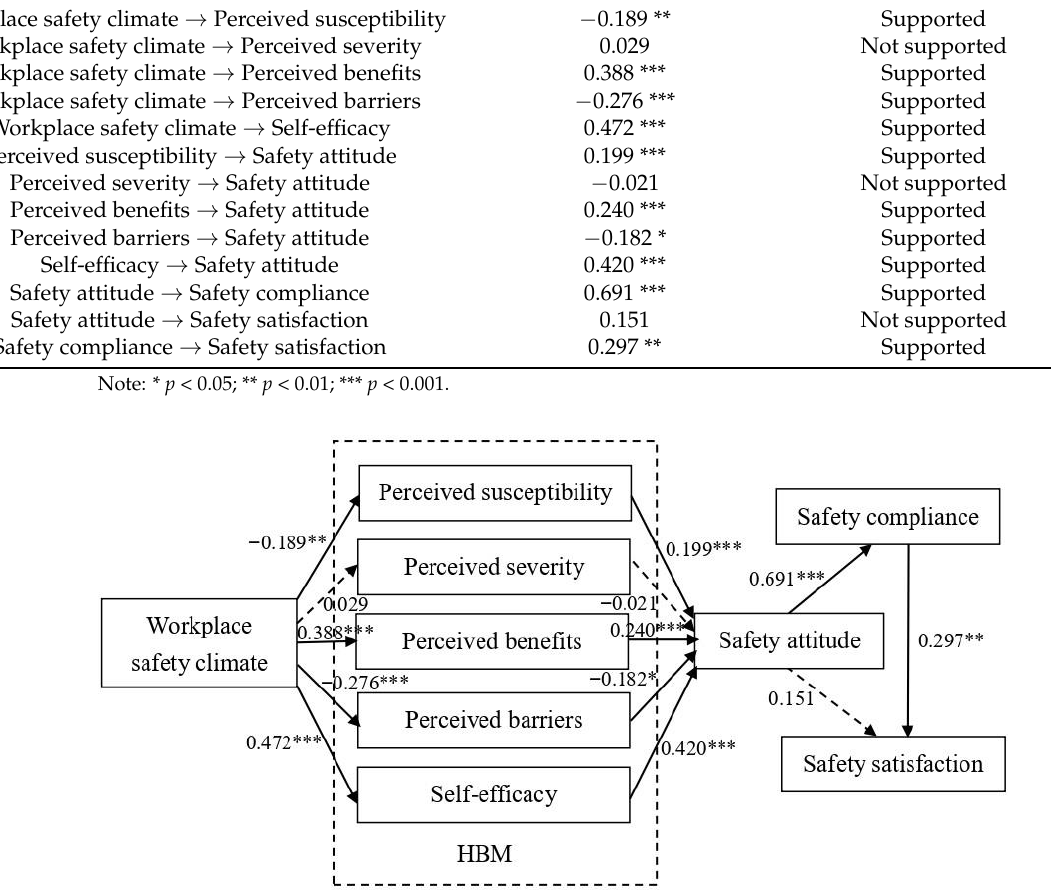
Figure 3. Results of structural model analysis. Note: * p < 0.05; ** p < 0.01; *** p < 0.001. Firstly, workplace safety climate had significant negative effects on perceived susceptibility and perceived barriers. The path coefficients were − 0.189 and − 0.276, respectively, and the p values were less than 0.01 and 0.001. This revealed that when the